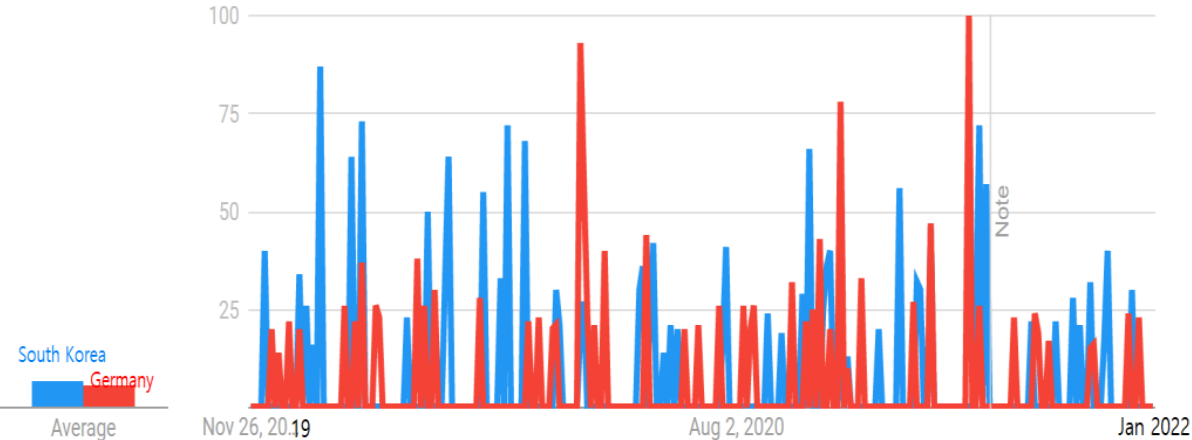
Figure 1. Number of newspaper articles about the smart city in South Korea and Germany (2018 – 2022). Source: Google Trends. : https://trends.google.com/trends/explore (accessed on 22 December 2022) [20].